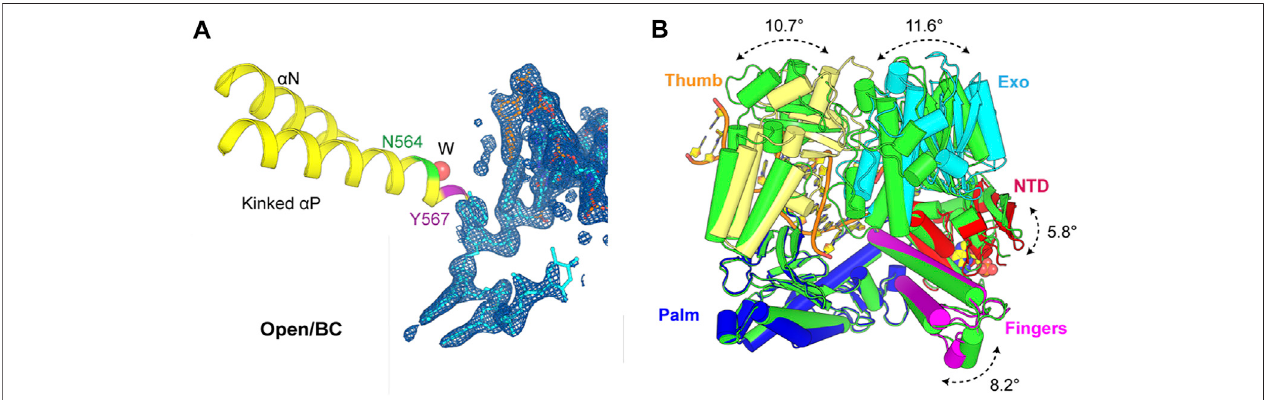
FIGURE3| Activesiteoftheopenbinarycomplex(MolB)andoverallstructurecomparisonwithapostructurereportedpreviously. (A) Openbinarycomplex(MolB) containing a vacant dNTP-binding site with one ordered water molecule (W) inserted into the backbone of the kinked helix p instead of the two observed in the apo structure. Asn564 and Tyr567 are in green and magenta, respectively. The 2 F obs - F calc electron density maps are contoured at 1.5 σ . (B) Exo (cyan), Thumb (yellow), Fingers (magenta), and NT (red) domains rotate relative to the Palm (blue) domain from this binary complex compared to the apo (green) structure by 11.6 ° , 10.7 ° , 8.2 ° , and 5.8 ° ,